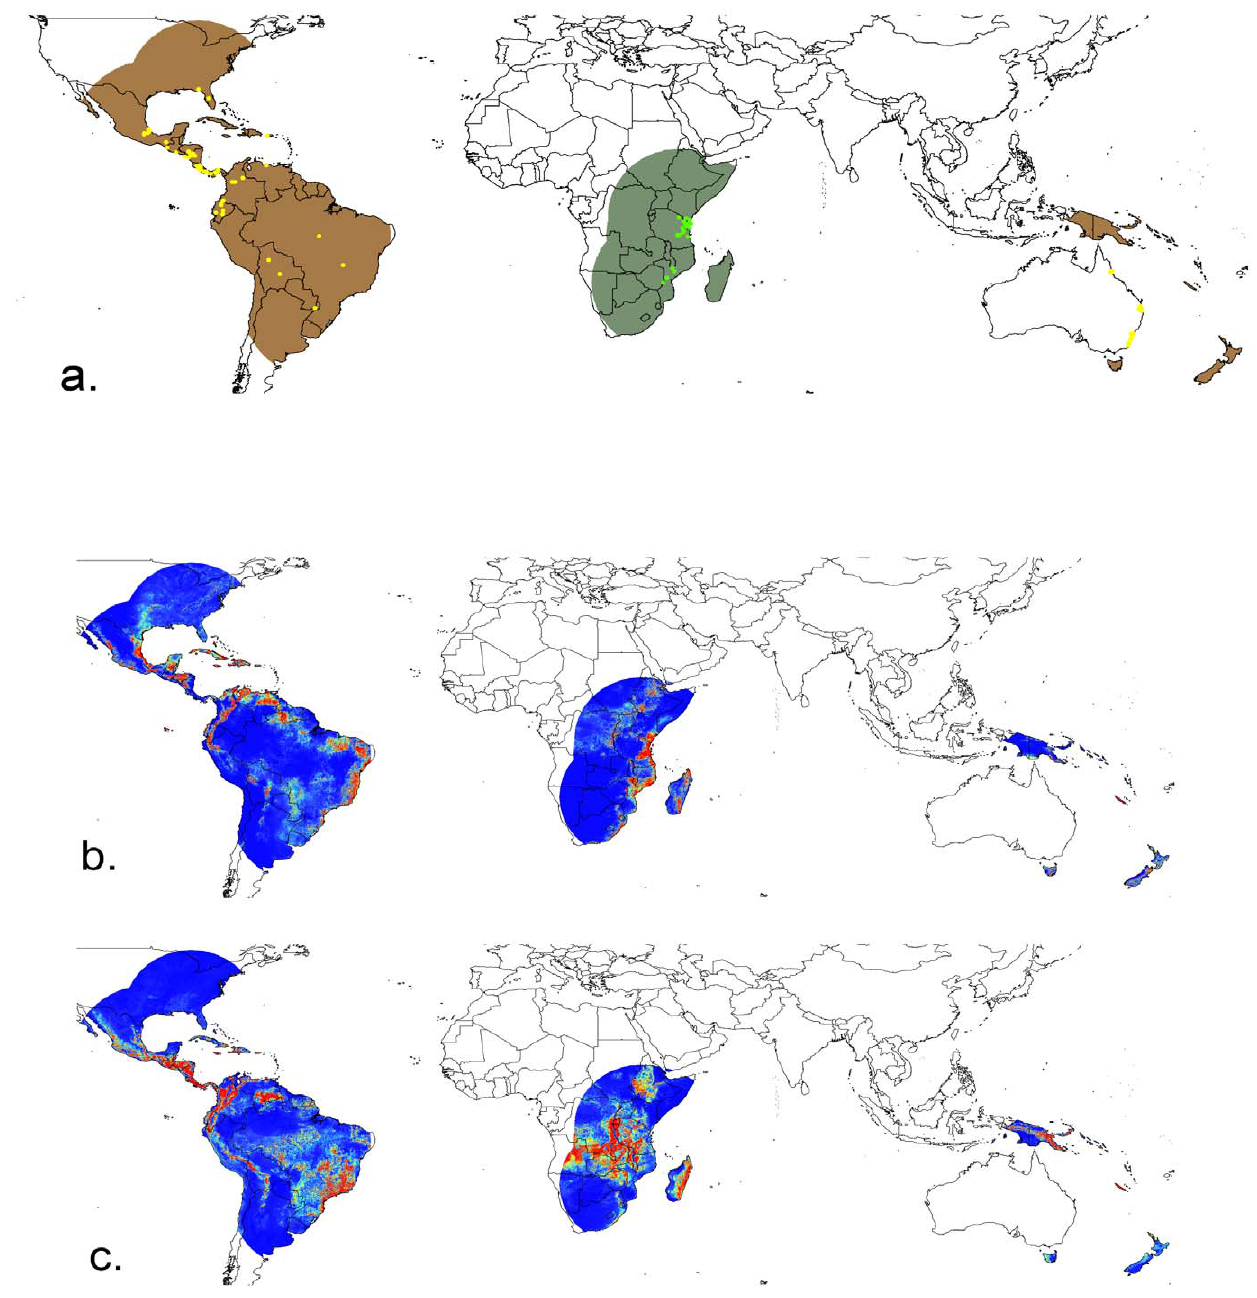
Figure 3. Study area and Maxent model predictions. Panel 3a shows the study region for native (green) and introduced (brown) study areas. Occurrence points are shown for native (bright green) and introduced (yellow) localities. Panels 3b and 3c show Maxent models built for native and introduced specimens, respectively. Warmer colors indicate habitat that is more suitable according to the model.